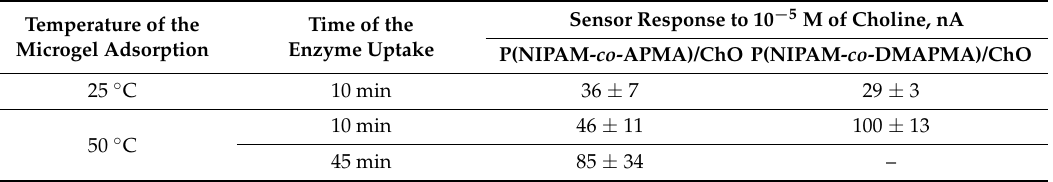
Figure 4. Sensor responses to choline (10 − 5 M) measured in 50 mM HEPES/30 mM KCl buffer (pH 7.5) at room temperature for the P(NIPAM- co -APMA)/ChO or P(NIPAM- co -DMAPMA)/ChO films vs. the enzyme adsorption time used for the biosensor preparation. Conditions of the fabrication of the microgel/enzyme films: (1) Adsorption of the microgels onto the SPE/MnO 2 -surface from 1 g/L solution at pH 9.3 at 50 °C for 1 h, followed by washing. (2) Uptake of ChO from 4 g/L solution at pH 7.0 at room temperature for a specified time, followed by washing. Lines through the experimentally obtained datapoints are drawn only as a guide to the eye. SPE stands for a screen-printed electrode. Table 2. Sensor responses for different microgel/enzyme biosensor constructs.